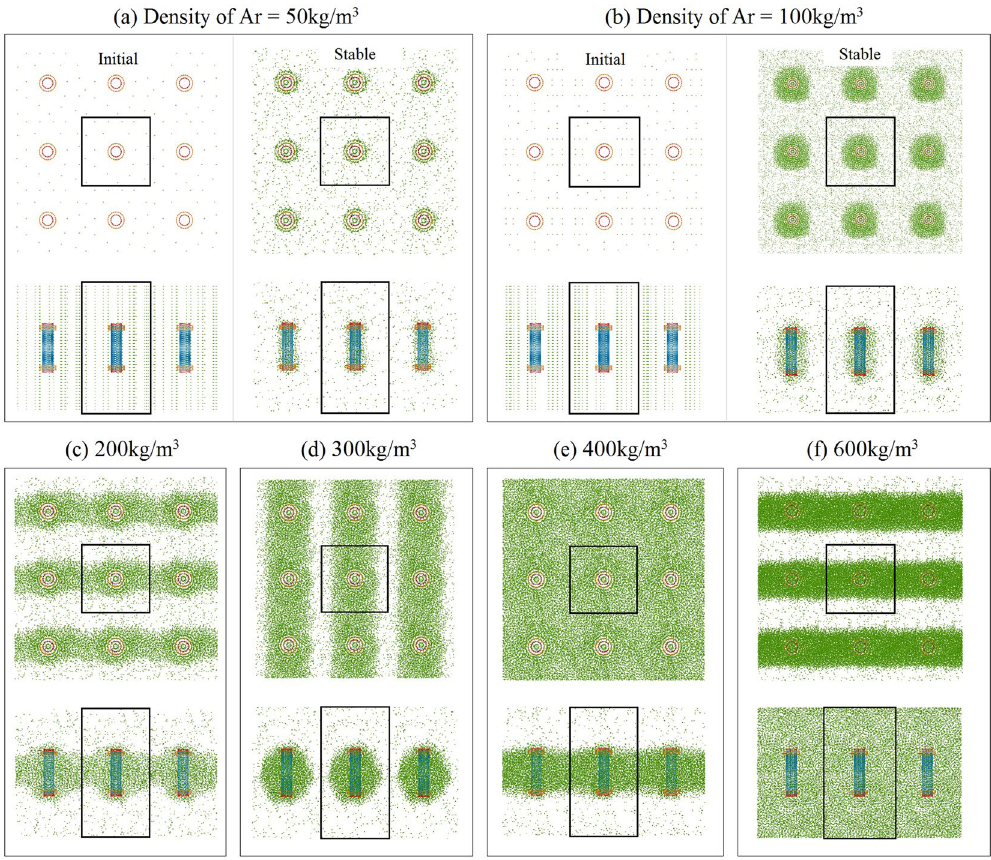
Figure 9. The configurations of the stable system with different densities of argon in the 3 × 3 boxes at 100 K. The inserted rectangles are the boundaries of a simulation box. In ( a ) and ( b ), both the initial and the stable states of the system are given. In ( c – f ), only the stable state is shown.